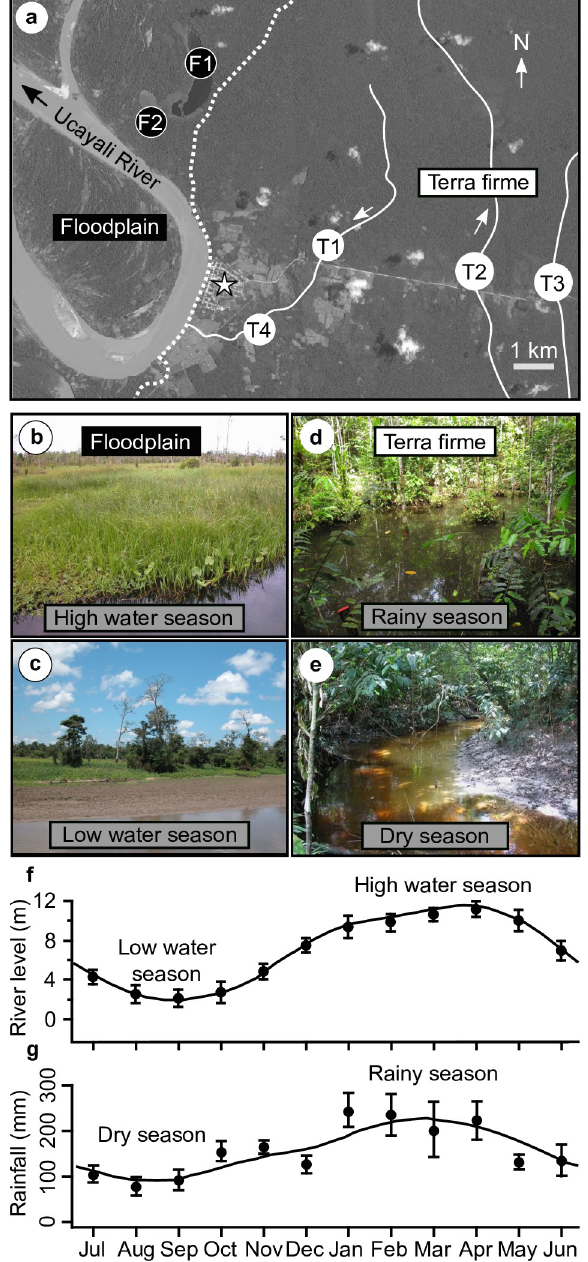
Fig 1. The study area and sampled habitats. a. Satellite image of vicinity of Jenaro Herrera (star), with floodplain lake sampling sites F1-F2 and terra firme stream sites T1-T4. Dotted line indicates low-water boundary of floodplain (to west) and terra firme systems. Arrows represent river/stream flow. b. Floodplain lake and macrophyte stand at high water. c. Floodplain lake at low water. d. Shallow swamp adjacent to terra firme stream in rainy season. e. Terra firme stream confined to its main course in dry season. f. Mean monthly Ucayali River level and g. mean monthly rainfall for 5-year period (2009–2013) from nearby (25 km) Requena meteorological station (data from Servicio Nacional de Meteorologı´a y Hidrologı´a del Peru´); error bars represent one standard deviation.